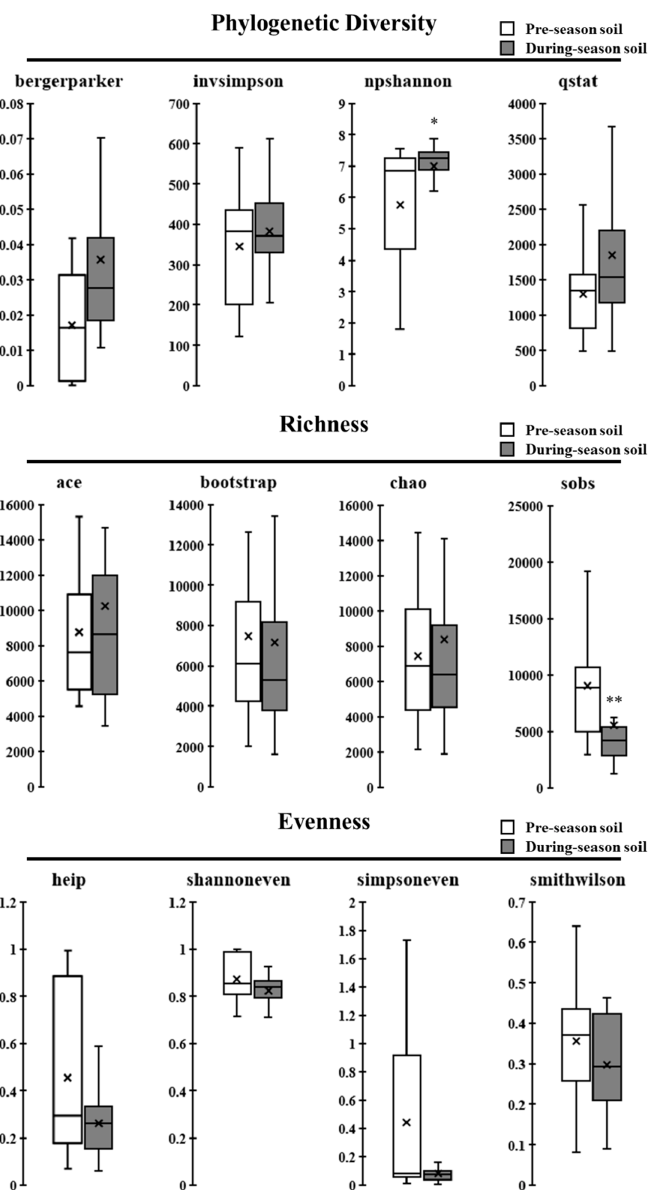
Figure 3. Bacterial diversity in the pre- and post-amended soil communities. Alpha diversity indexes of bergerparker, invsimpson, npshannon, and qstat (phylogenic diversity), ace, bootstrap, chao, and sobs (richness), and heip, shannoneven, simpsoneven, and smithwilson (evenness) for pre- and post-amended soil samples. * and ** indicate significant differences in comparison with pre-amended soil at p < 0.05 and p < 0.01, respectively. × indicates the mean value of the group.